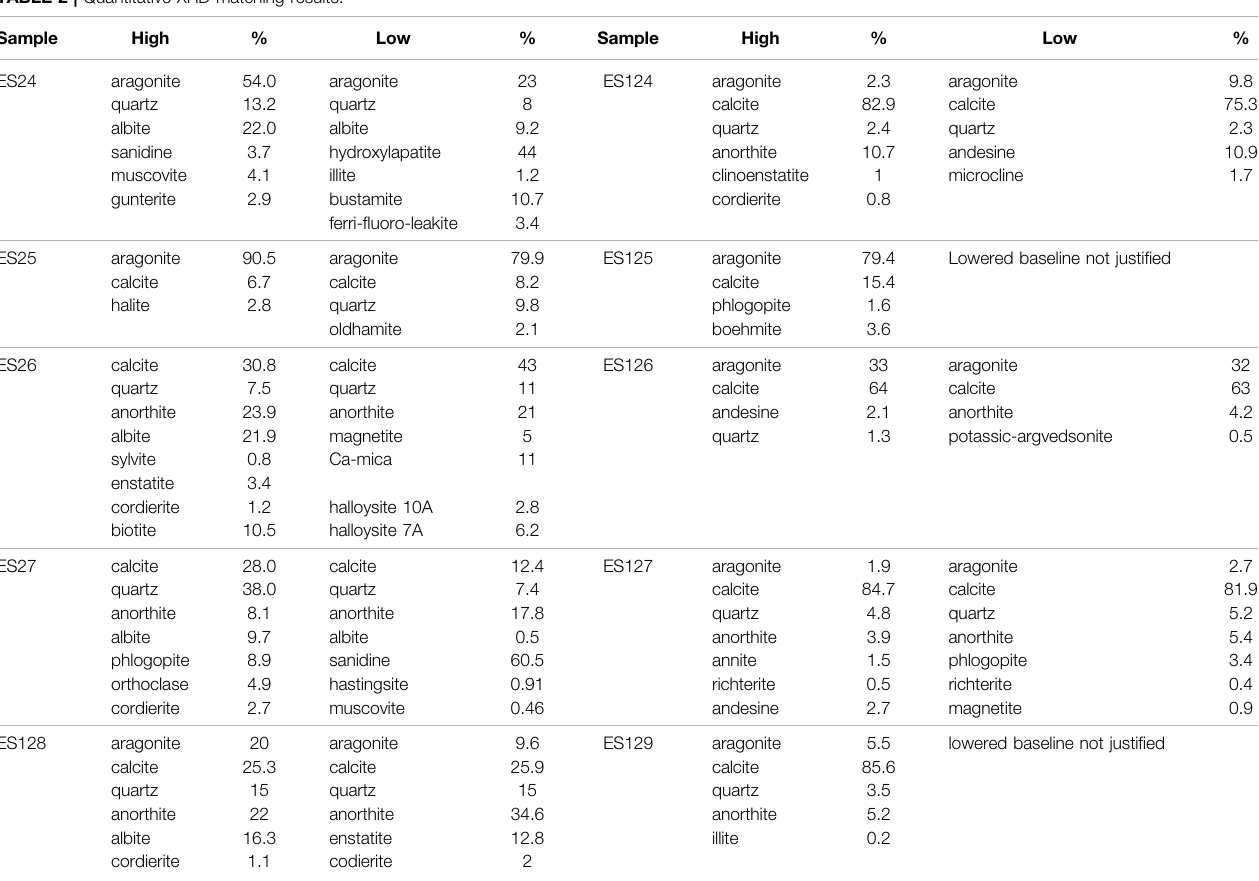
TABLE 2 | Quantitative XRD matching